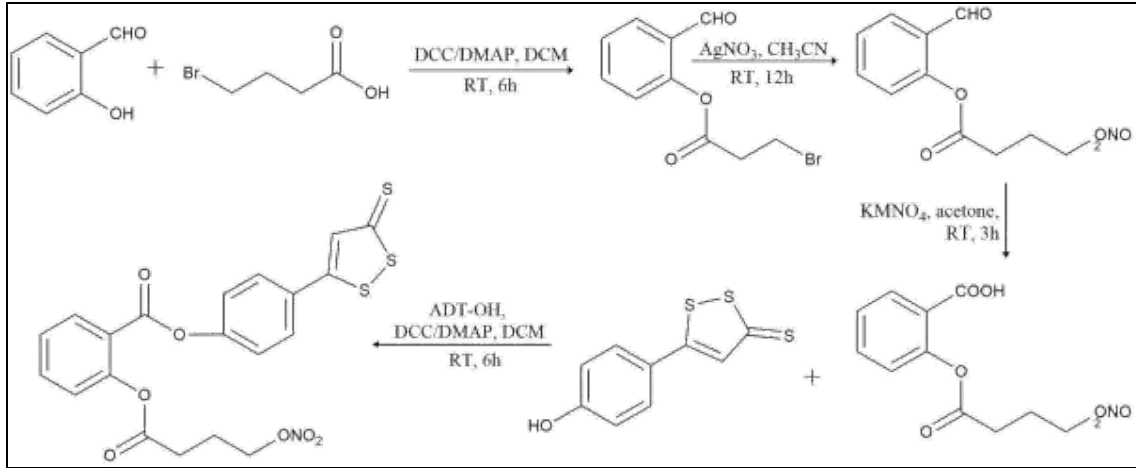
Fig. 5. Thiourea Structure